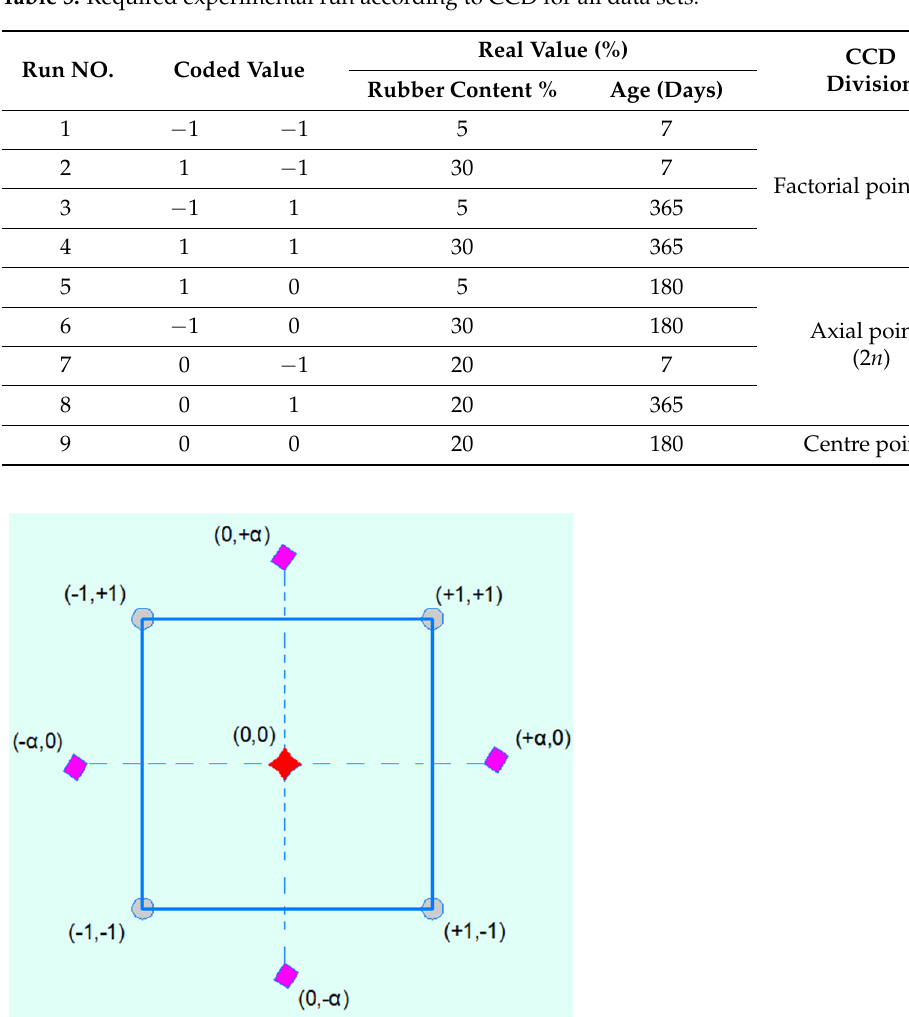
Figure 4. Basic concept of experimental design using CCD-RSM model. Table 5. Required experimental run according to CCD for all data sets.